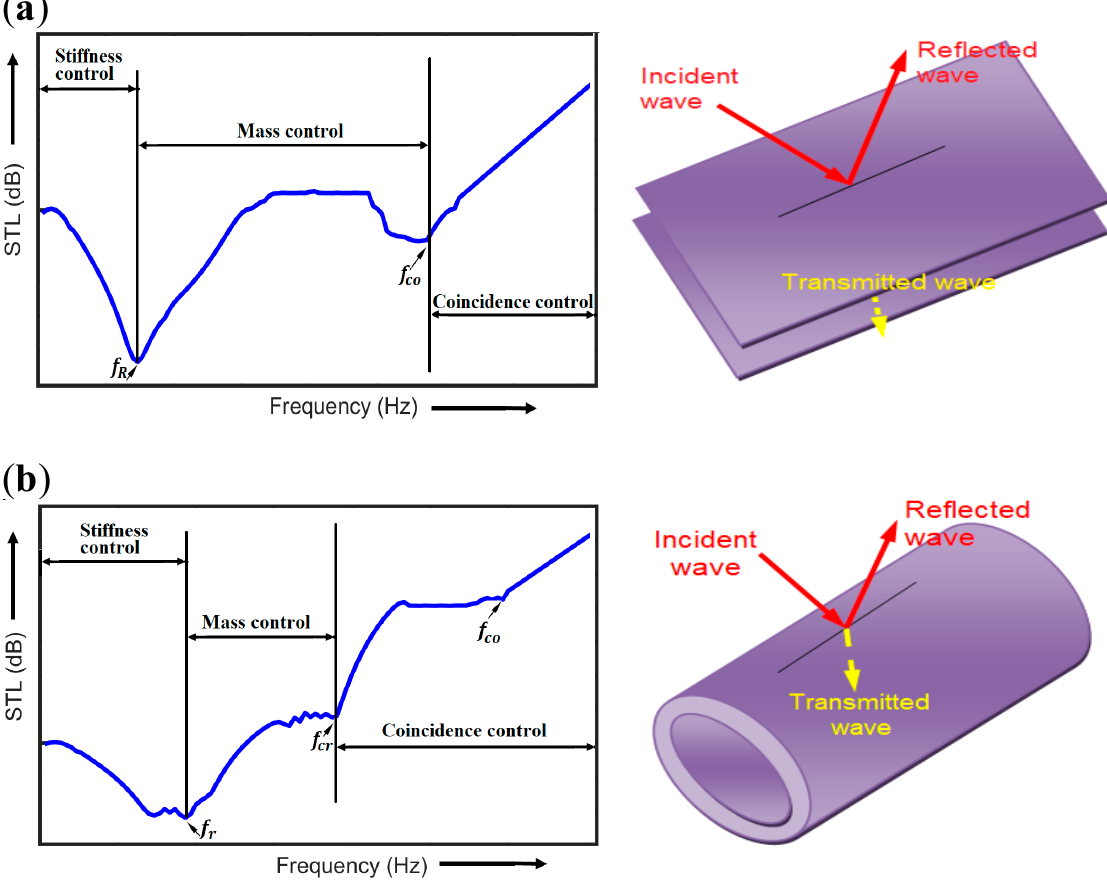
Figure 1. Typical representation of sound transmission loss (STL) curve with different frequency characteristics controlled regions for ( a ) flat or rectangular double panel structures (DPS) ( b ) cylindrical or curved DPS.